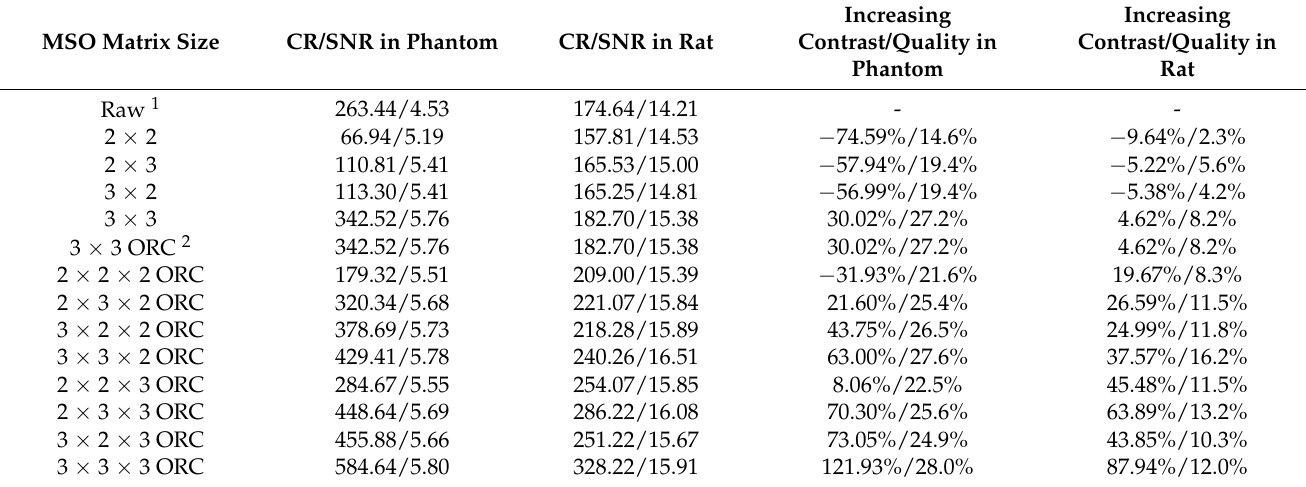
Table 3. The contrast ratio and signal-to-noise ratio were calculated for Deluxe Jaszczak phantom and rat images and were processed by 2D- and 3D-MSO. The percentage of increasing quality is defined as (SNR after MSO − SNR in Raw)/(SNR in Raw) × 100%. The CR is defined as (Mean intensity of Region in Phantom or rat)/(Mean intensity of background in Phantom or rat). The percentage of increasing contrast is defined as (CR in Region − CR in Background)/(CR in Background) × 100%.